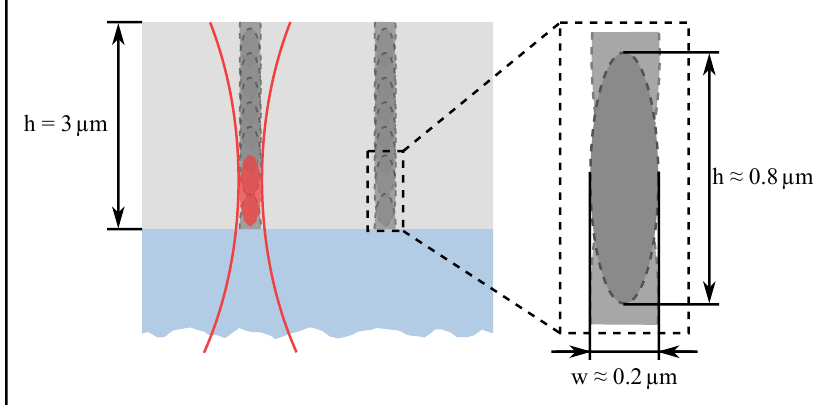
Figure 1. Schematic drawing of a three-dimensional direct laser writing (3D DLW) writing process. The blue area in the figure depicts the substrate, the light gray area the unexposed photoresist, the dark gray areas the exposed photoresist, the red lines approximate the envelope of the laser beam used for exposure, which is strongly focused by an objective with a high numerical aperture and the red area illustrates the focal volume (voxel) in which the polymerization occurs. The right side shows an enlarged illustration of a voxel with the approximate